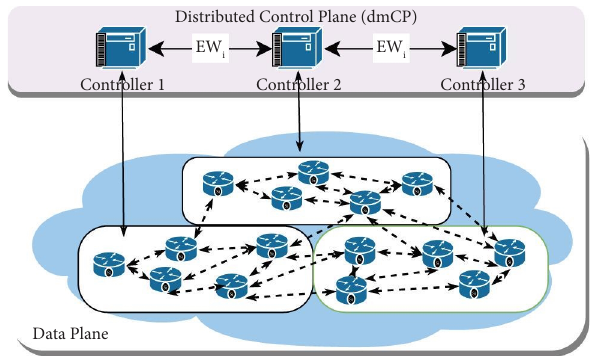
Figure 5: Multiple control plane